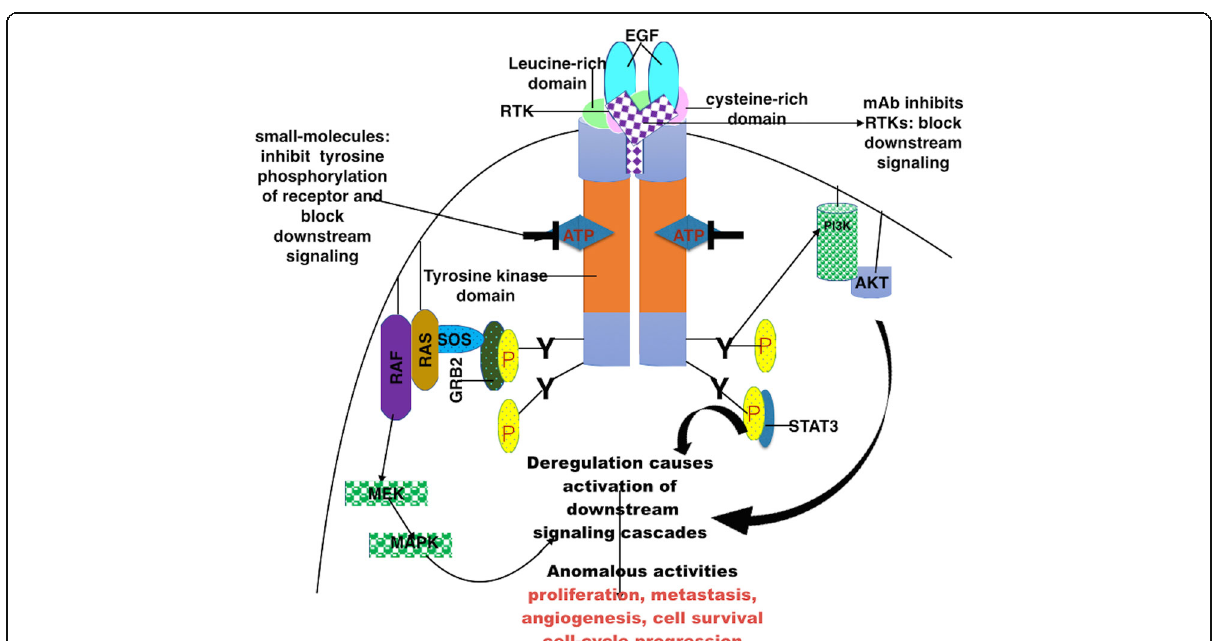
Fig. 2 Mechanisms of RTKs (EGFR) signal transduction, small molecule inhibition and monoclonal antibody inhibition in target therapy. This depicts EGFR and RTK signaling. The extracellular domain is Leucine-rich binding domain and cysteine-rich domains, the kinase domain is the ATP catalytic domain and the C-terminal domain is composed of tyrosine residues (Y). The Ras – Raf – MEK – MAPK pathway is activated through stimulation by growth factor receptor. The phosphatidylinositol 3-kinase (PI3K) – AKT and signal transducer and activator of transcription (STAT) proteins (STAT1, STAT3, and STAT5) are also activated. The synergistic effects of these pathways bring about proliferation, cell survival, cell motility, adhesion, and angiogenesis. Deregulation of the pathway causes activation of the downstream oncogenic signaling cascades. Small-molecule tyrosine kinase inhibitors block downstream signaling by competitively competing for the ATP at the catalytic site of the kinase domain while monoclonal antibodies (mAbs) with an outstanding degree of specificity block signaling by binding to the leucine-rich and cysteine-rich ectodomain (cetuximab in